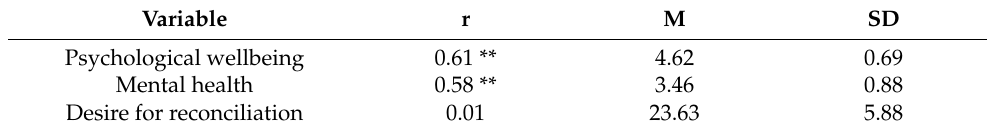
Table 5. Descriptive statistics and correlations (r) between HFS and psychological wellbeing, mental health, and desire for reconciliation obtained in the validity study ( n =